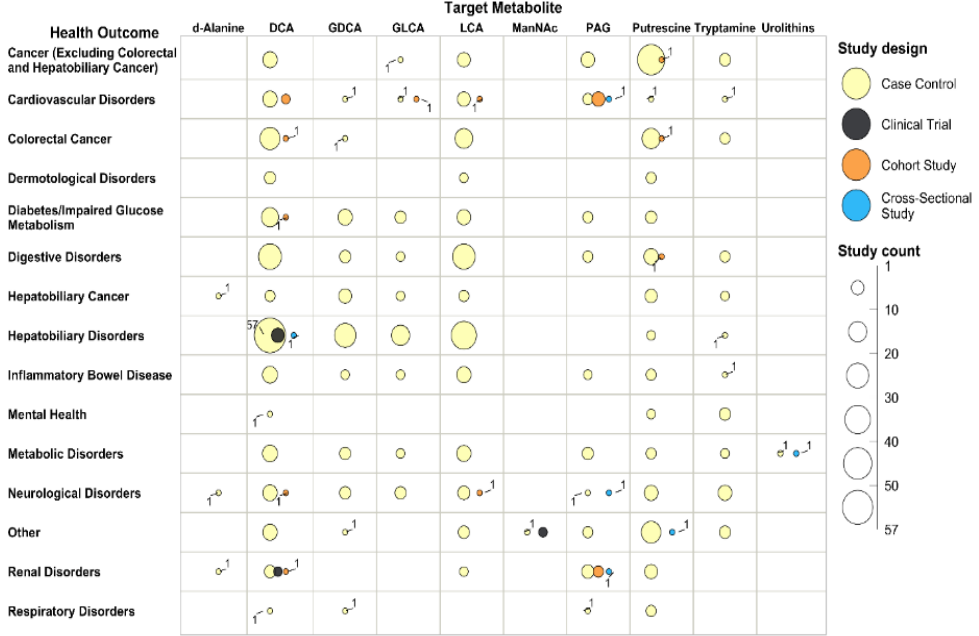
Figure 3. Bubble Plot for Relationships or Patterns between Metabolites, Health Outcomes, and Study Design with Bubble Size Relative to the Number of Studies. Abbreviations: DCA: Deoxycholate (Deoxycholic Acid); LCA: Lithocholate (Lithocholic Acid); GDCA: Glycodeoxycholate (Glycodeoxycholic Acid); PAG: Phenylacetylglutamine; GDCA: Glycolithocholate (Glycolithocholic Acid); ManNAc: N-Acetylmannosamine.